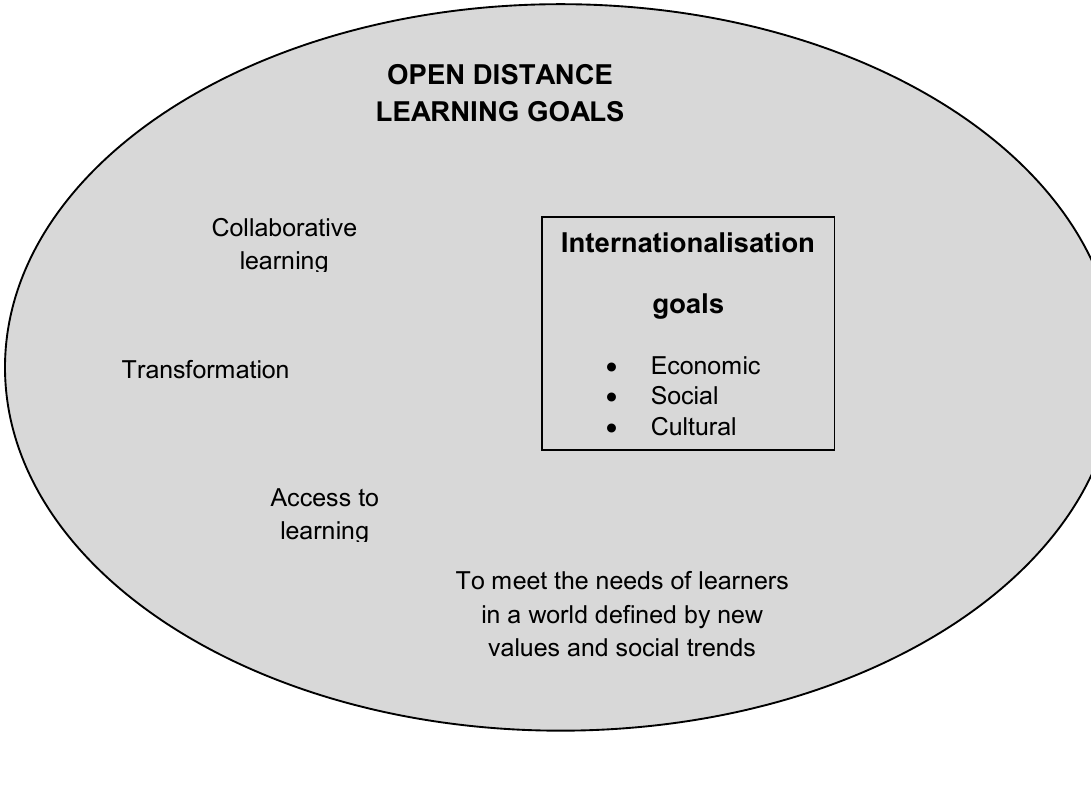
Figure 1 . Internationalisation goals as a subset of ODL